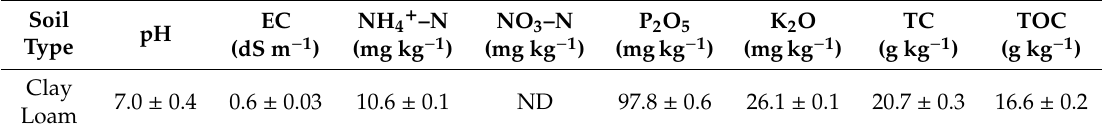
Table 3. Soil physicochemical properties of experimental field 1